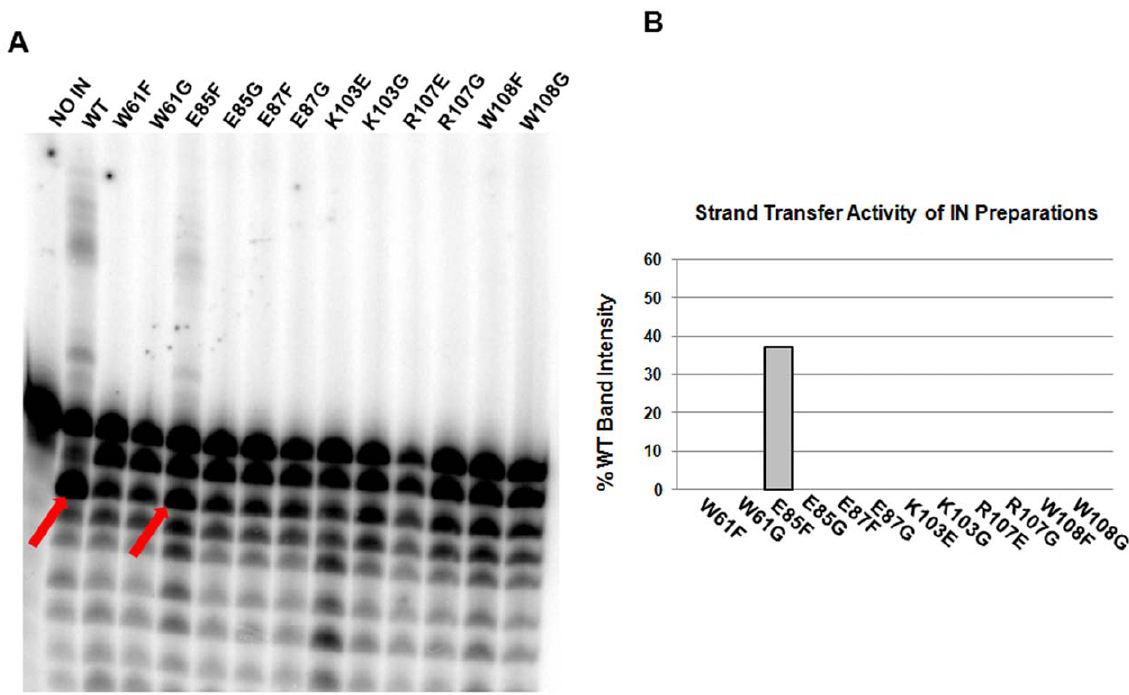
Figure 4. Dimeric interface mutations abrogate IN catalysis. (A) The strand transfer activity of partly-purified mutant IN proteins with 21-mer substrate. (B) E85F is the only mutant protein that exhibited strand transfer activity in the presence of radiolabeled 21-mer oligonucleotide